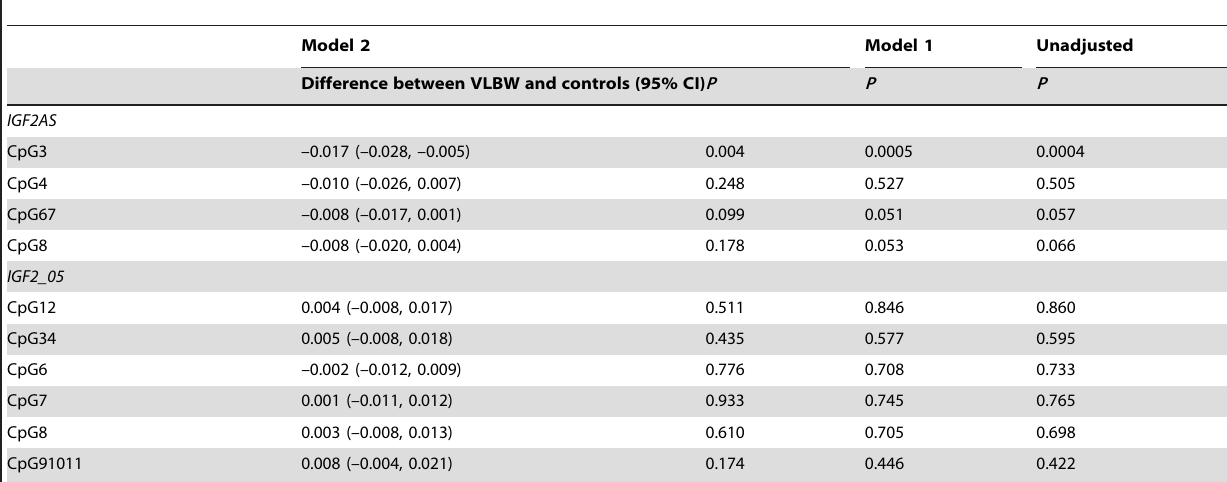
Table 4. Differences in methylation fractions at different IGF2 CpG units between VLBW and controls by linear regression.